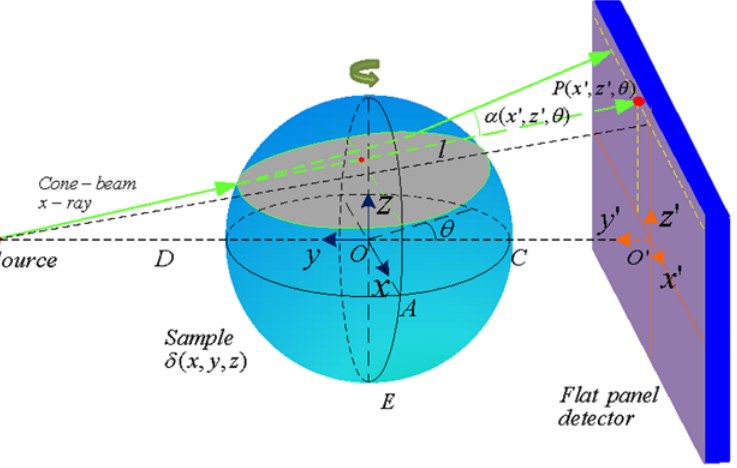
Fig 1. Schematic geometry of x-ray refraction in a medium for cone-beam DPC-CT. ( x 0 , z 0 ) represents the coordinates of the detector plane. OAC is the mid-plane. D is the distance from the source to the rotation center O . θ represents the view angle under which the data was taken. l is any incident ray in the three dimensional space under θ . P is the line integral of δ along l .